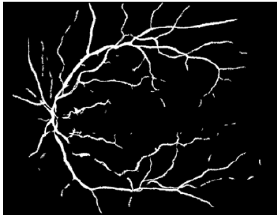
Fig. 8. The result of retinal vessels detection